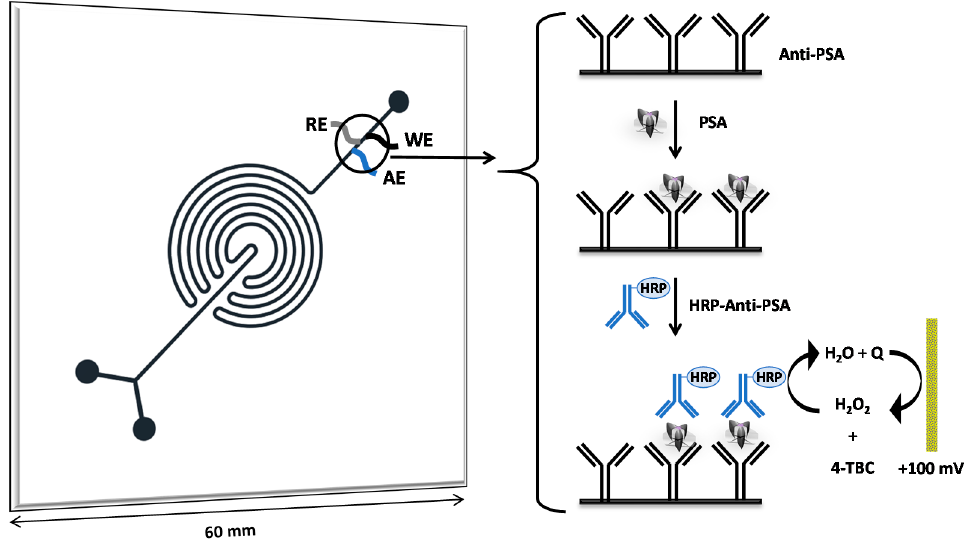
Figure 1. Representative scheme of microfluidic immunosensor device for PSA quantification.